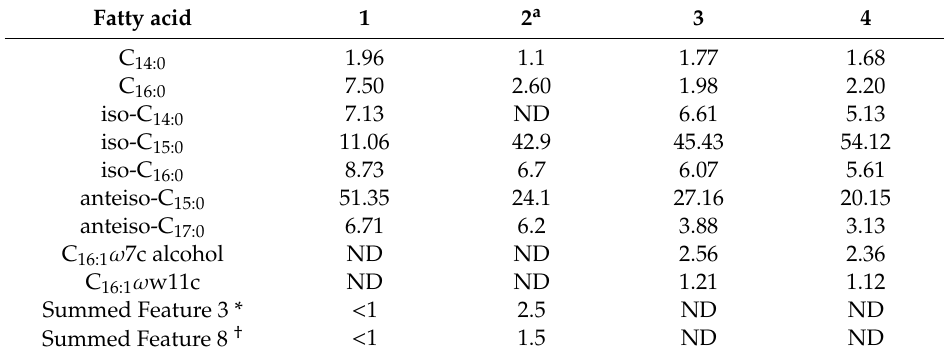
Table 2. The cellular fatty acid content of strain 03113 T and representative strains of closely related species of the genus Bacillus . Strains: 1, 03113 T ; 2, B. dabaoshanensis CCTCC AB 2013260 T ; 3, B. solani CCTCC AB 2014277 T ; 4, B. praedii CCTCC AB 2015208 T . All data were obtained in this study. Partial values lower than 1% are not shown in the table. ND, Not